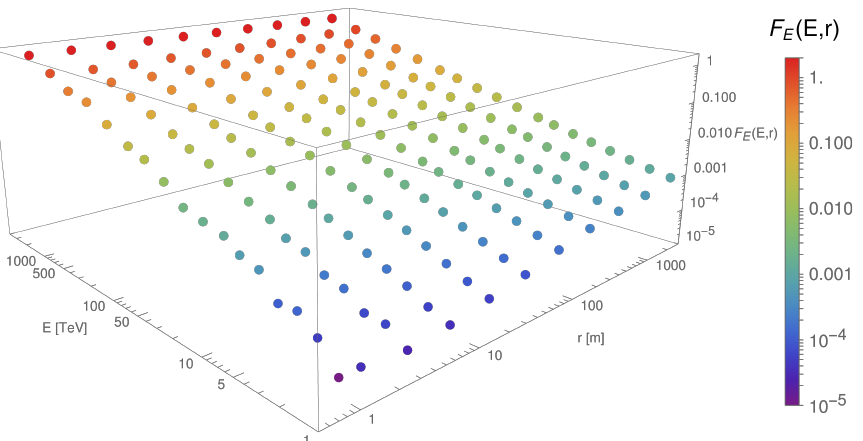
Figure 2. Scaling factor F E ( E , r ) normalised to unity for E norm = 4000 TeV as a function of the distance r and energy E , obtained for vertical cascades initiated by cosmic-ray